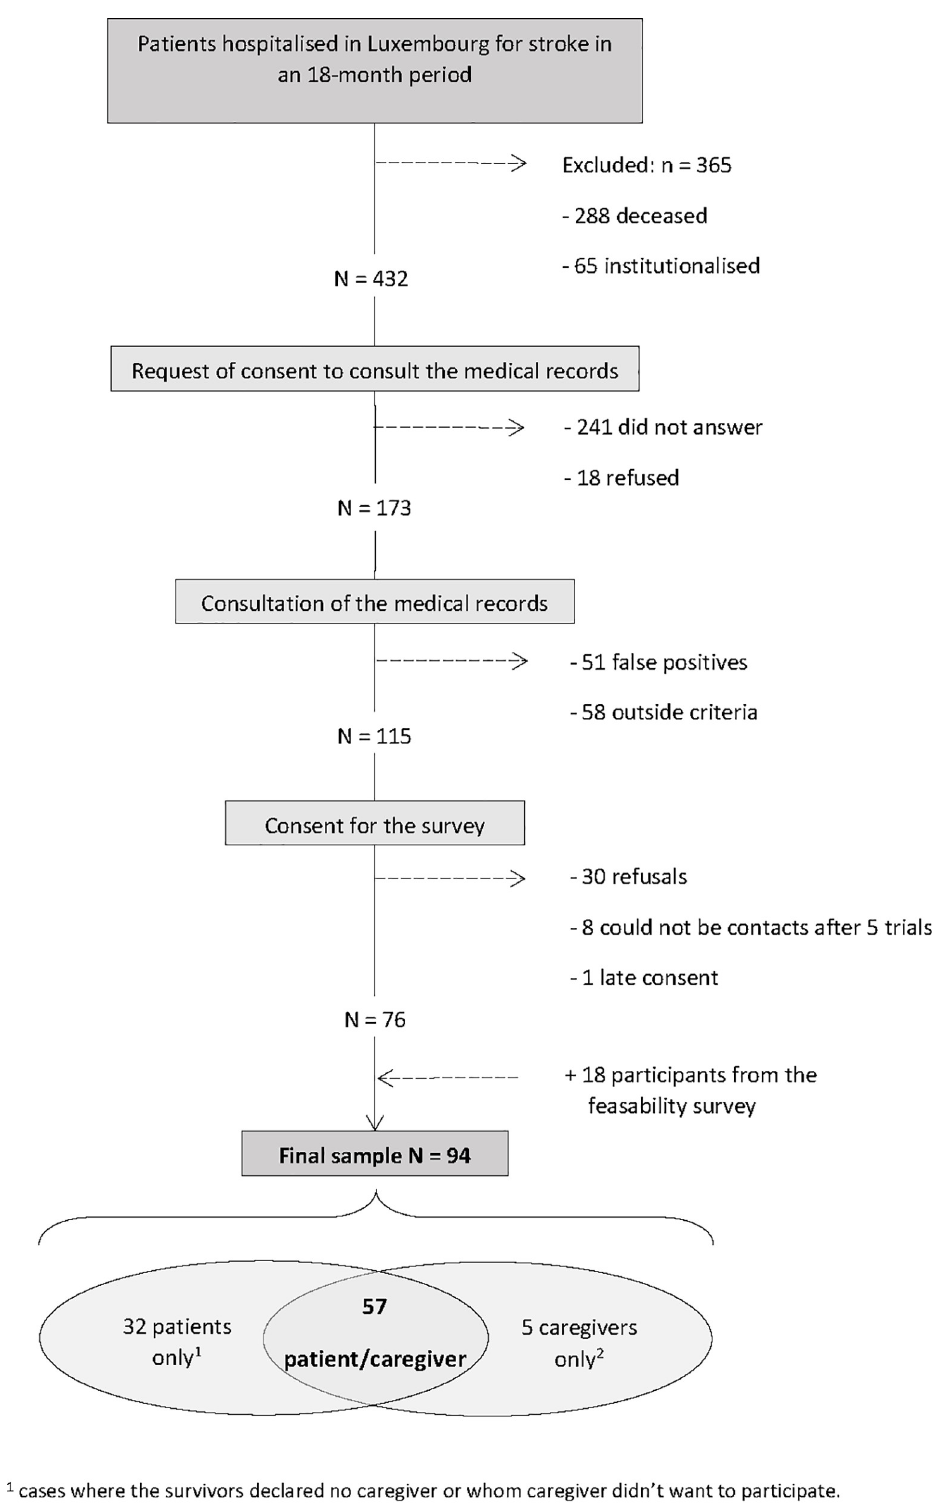
Fig 1. Description of the sampling